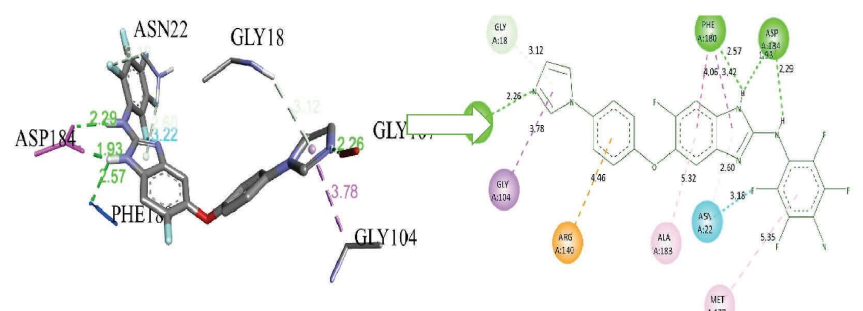
Figure 5: 3D and 2D binding interaction of A15 with FtsZ protein.